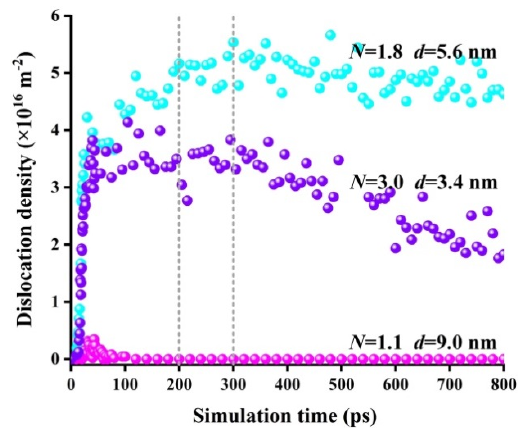
Figure 7. The relationship between the simulation time and the dislocation density in different models during the torsion simulation.